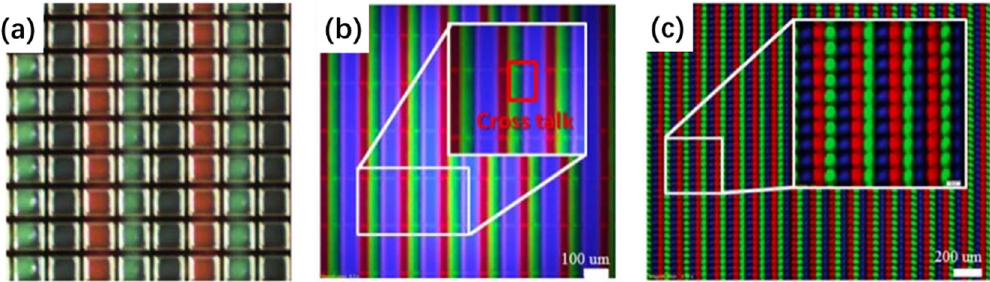
Figure 11. ( a ) QD micro-LED array with the anti-crosstalk mold; ( b ) fluorescence microscope image of the QD micro-LED array without the crosstalk prevention mold; ( c ) fluorescence microscope image of the QD micro-LED array with the anti-crosstalk mold. Reproduced from [76], Photonics Research, 2017.